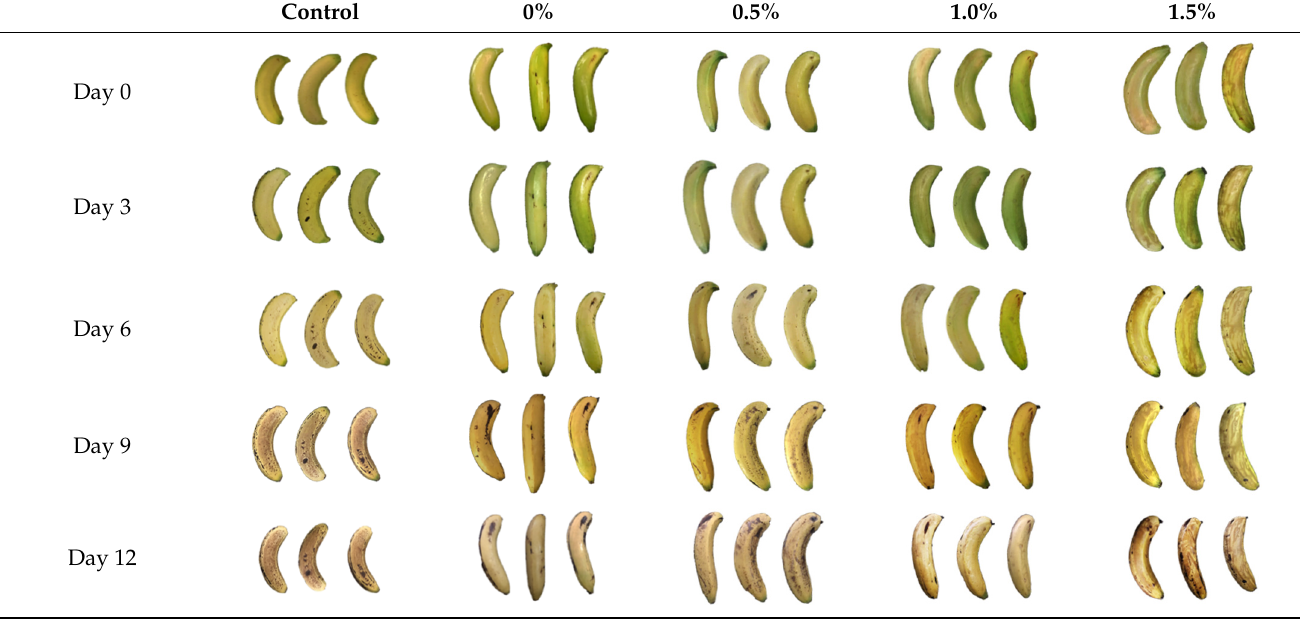
Table 5. Effect on appearance changes of banana coated with different concentrations of D-limonene nanoemulsion edible film and stored at 13 ± 1 °C from 0 to 12 days.